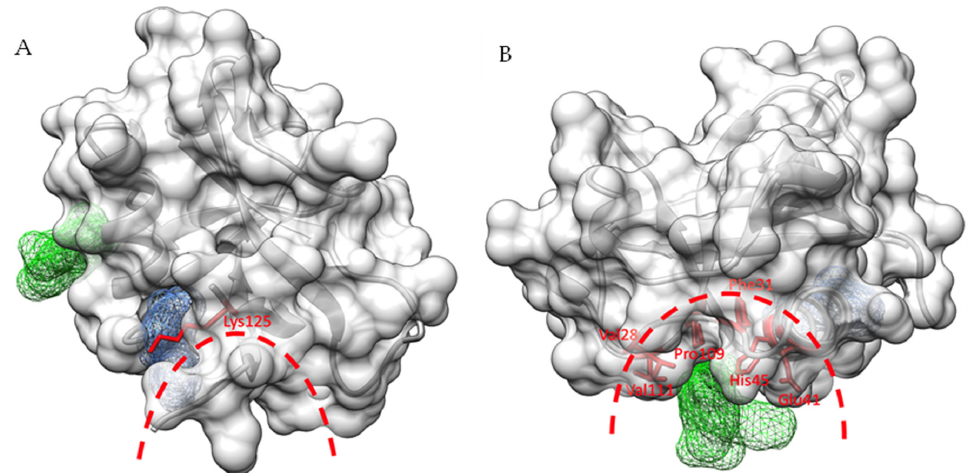
Figure 6. The close relationship in space between two binding pockets and targets in host cells. ( A ) The close spatial proximity between binding pocket I (blue mesh) and the predicted RNA binding region, indicated by the red dashed line. The shared key residue Lys125 is shown in red as a ball- and-stick model. ( B ) The spatial overlap between binding pocket II (green mesh) and the interacting surface with the primosome is indicated by the red dashed line. The shared key residues Val28, Phe31, Glu41, His45, Pro109 and Val111 are shown in red as ball-and-stick models. Recently, Mou and co-workers, investigated close to 300,000 fully sequenced SARS- CoV-2 genomes for mutations in nsp1 [51]. For full-length nsp1 containing 180 residues they identified 933 non-synonymous mutations in the entire coding region, identifying at least one mutation for each single residue. The 19 most common mutations with a fre- quency between 113 and 1122 were reported. By comparing residues forming binding pocket I (Table 2) with the 19 residues with the highest frequency we conclude that none of the residues of this binding site belongs to the group with highest frequency, indicating that these residues do not seem to be among the group of residues that mutate easily. However, all residues in binding site I display some tendency to mutate with frequencies between 4 and 9. As binding pocket II is very shallow, only a limited number of SARS- CoV-2 nsp1 10-126 residues establish interactions with the fragment hits. Interestingly, one of the three residues, His45, belongs to the group of residues with most frequent muta- tions. However, since the interaction occurs via the main chain but not through the side chain, this mutation should have no significant effect, in case they do not significantly alter the local structure. In contrast, in the symmetry mate, Arg24 is one of the residues forming the ligand binding pocket. This residue shows the tendency to mutate with the highest frequency (1122) of all residues. In conclusion, binding pocket II is not only shal- lower than binding pocket I, but its residues involved in the formation of the pocket also show a higher tendency to mutate. We hypothesise that SARS-CoV-2 may be able to over- come inhibitors in binding pocket II by either mutating key residues involved in inhibitor binding, or through primary resistance as mutations may already be present in the virus. 2.11. The Rationale for Targeting N- and C-Terminal Domains of Nsp1 After infection of host cells, SARS-CoV-2 nsp1 can bind to the 40 S subunit of host ribosomes to block the entry of the host mRNA expression channel through its C-terminal domain. The C-terminal domain is connected by a linker region to its N-terminal globular domain, which remains tethered around the entry site [30]. As a result, host mRNAs are inaccessible to the expression cleft. Therefore, the host ribosome is hijacked by SARS-CoV- 2 nsp1 to mainly serve the production of viral proteins. Targeting the C-terminal SARS-